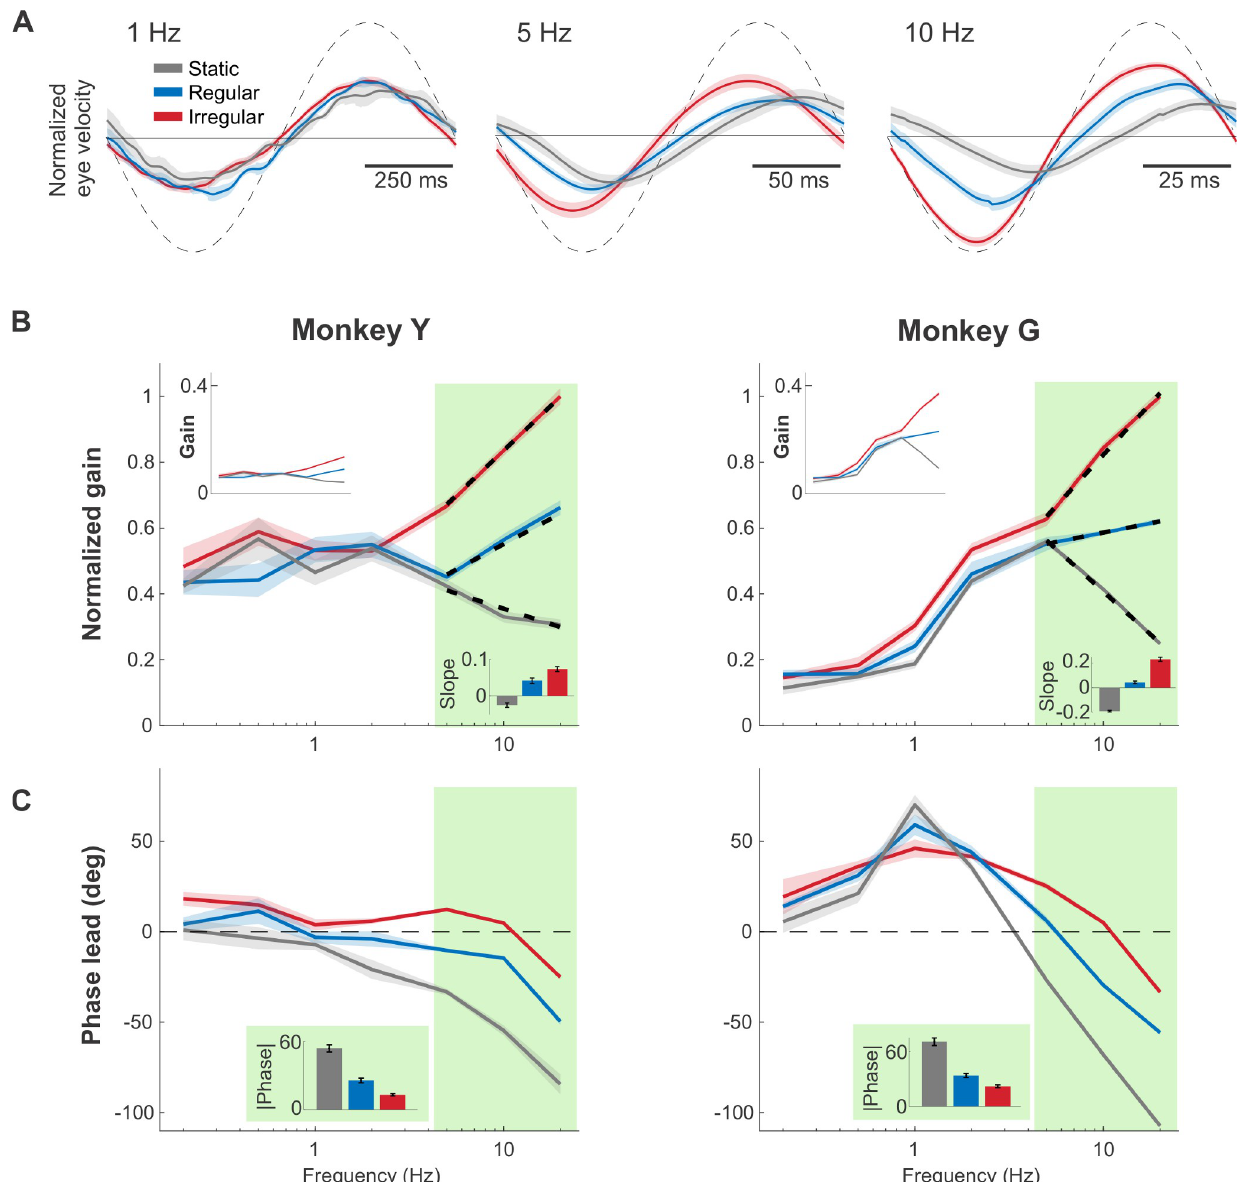
Fig 2. Afferent-like high-pass dynamics helped maintain robust VOR gains and minimize VOR phase lags at high head rotation frequencies. ( A ) Example traces of the evoked eye movements during 1, 5, and 10 Hz virtual sinusoidal rotations, normalized to the peak evoked response (i.e., response evoked by the irregular mapping at 20 Hz). Note that the vestibular prosthesis stimulation induced contralaterally versus ipsilaterally directed VOR eye movements in response to increasing versus decreasing stimulation rate relative to the baseline, respectively. Dashed line indicated the simulated head velocity, scaled to facilitate phase response comparison. ( B ) The normalized VOR gains across natural frequency range (0.2–20 Hz), using the same normalization reference as in ( A ). The shaded areas around each trace indicate ± SEM. Light green shading indicates the higher frequencies (5–20 Hz) where the differences between each mapping are more pronounced. The superimposed dashed lines are the log-linear fit over the high frequency range. (Top inset) The VOR gain prior to normalization. (Bottom inset) The log-linear slope of the fit. ( C ) The phase response of the VOR. (Inset) The mean absolute phase at the high frequencies for each mapping. Red, blue, and gray refer to the irregular, regular, and static mappings, respectively. Data underlying this figure can be found at https://doi.org/10.5281/zenodo.6338639.